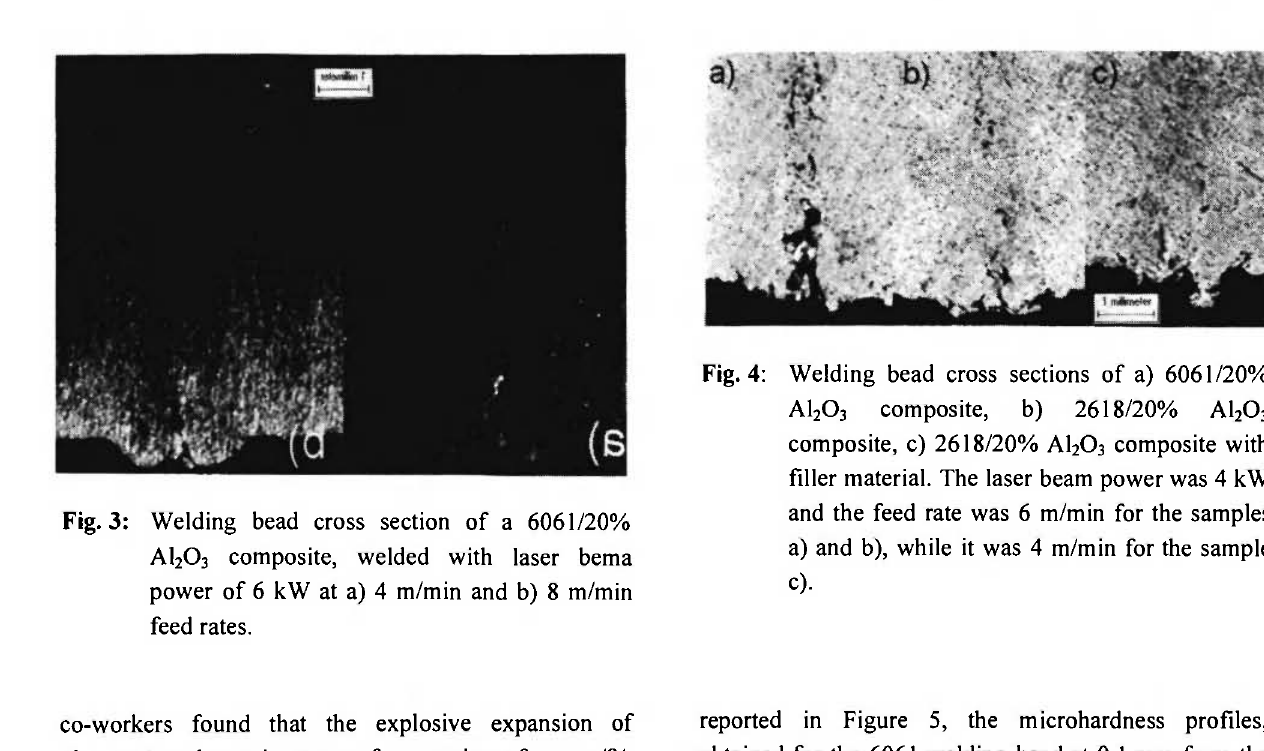
Fig. 3: Welding bead cross section of a 6061/20% A1 2 0 3 composite, welded with laser bema power of 6 kW at a) 4 m/min and b) 8 m/min feed rates.